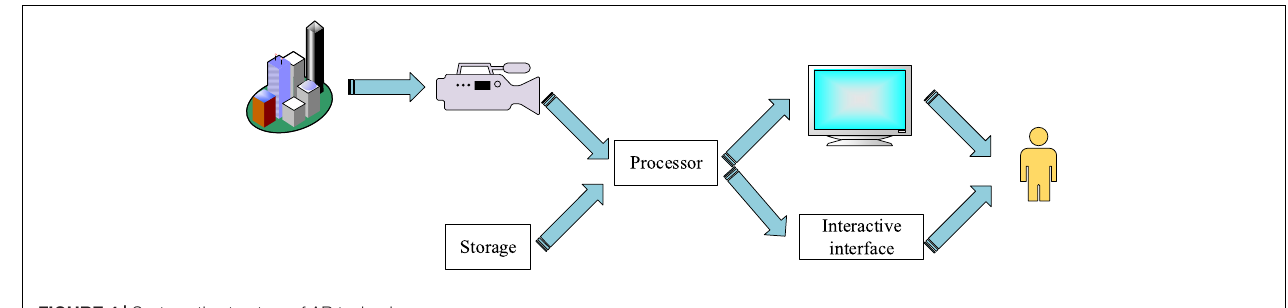
FIGURE 4 | Systematic structure of AR technology.